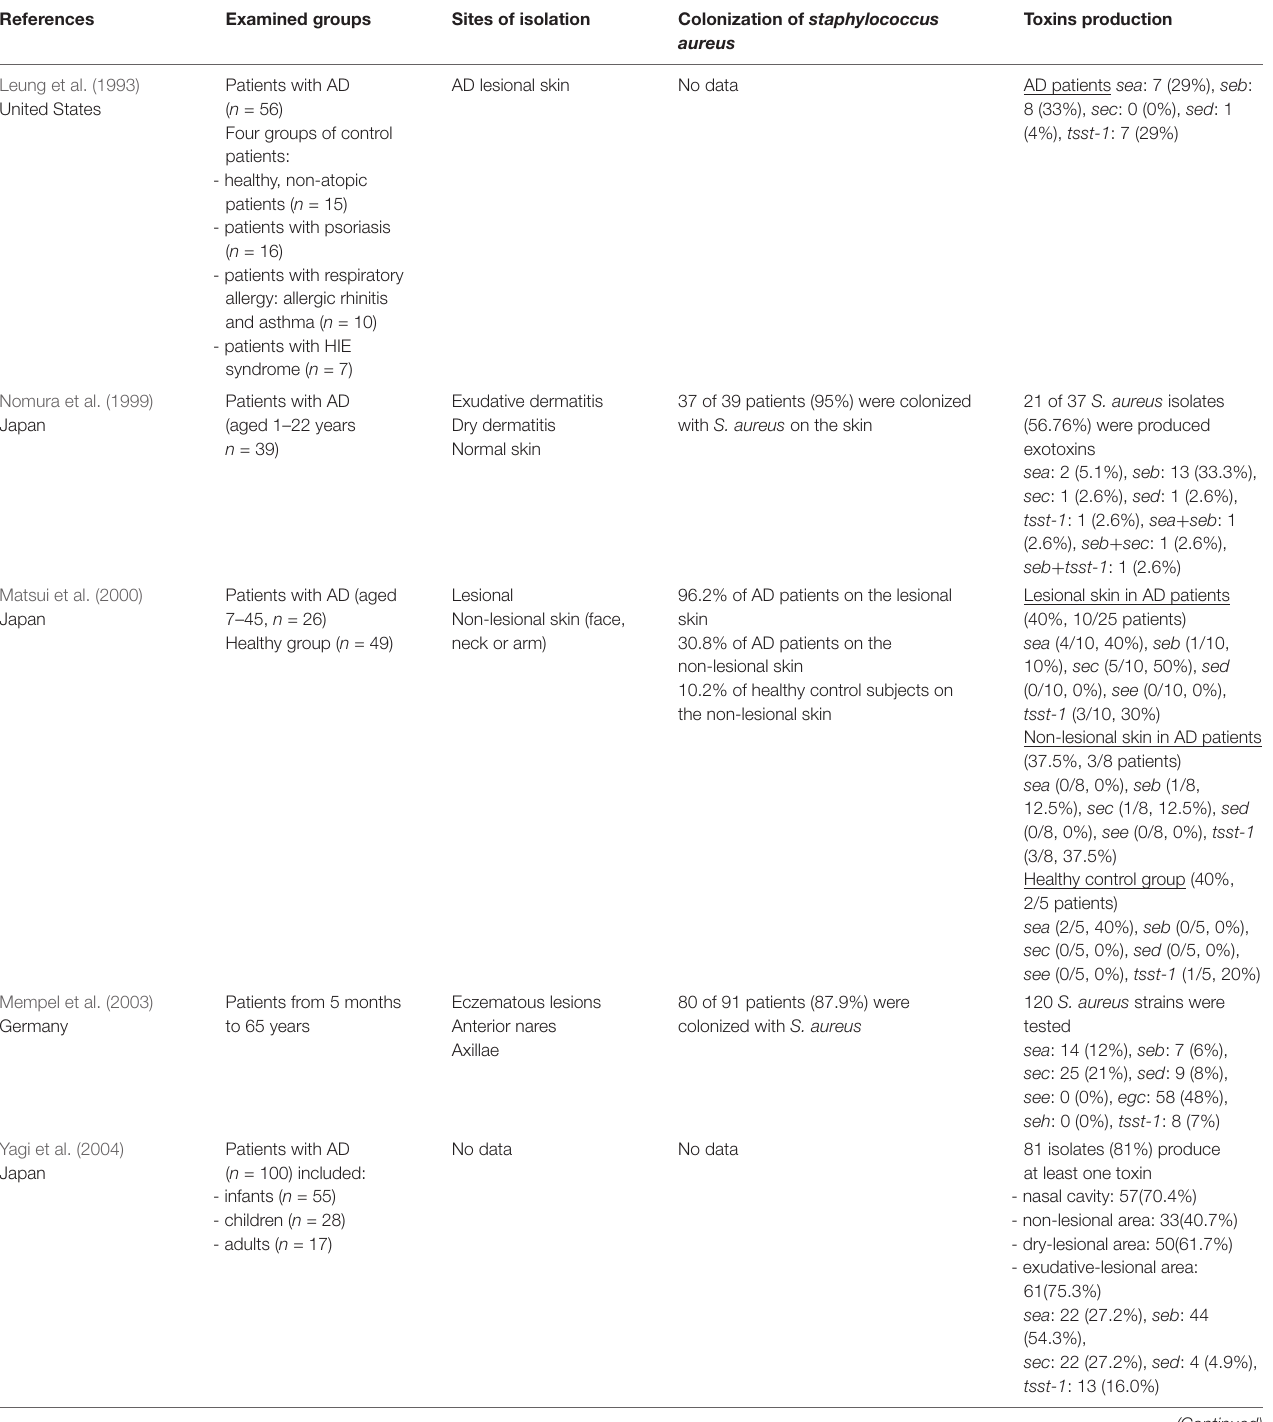
TABLE 3 | The distribution of S. aureus colonization and toxins production in combined groups of AD patients (both children and adults